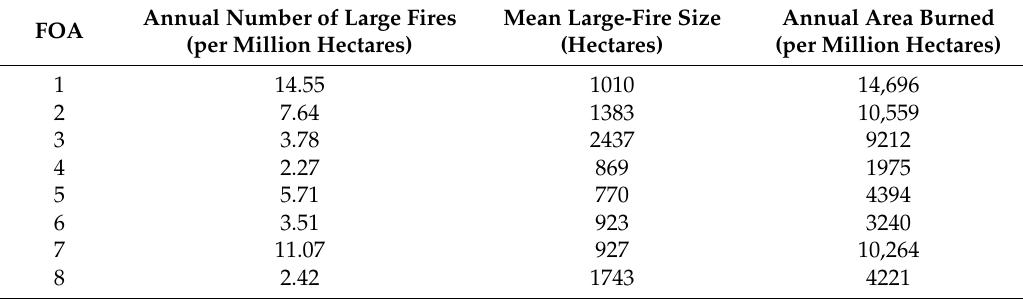
Table 4. Summary of historical mean annual number of fires per million hectares, mean size of large fires, and mean large-fire annual area burned per million hectares by fire occurrence area (FOA). FOA